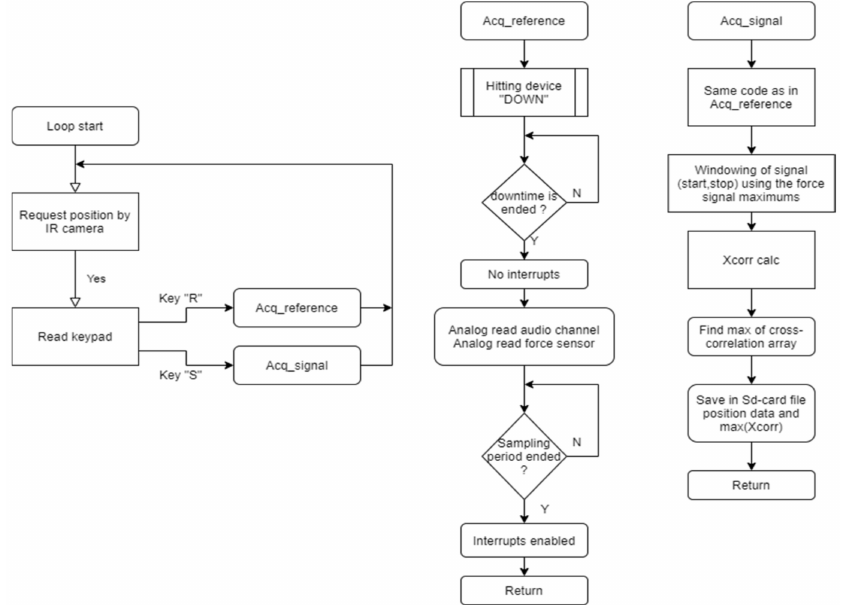
Figure 6. The flow chart of the implemented software (audio section).